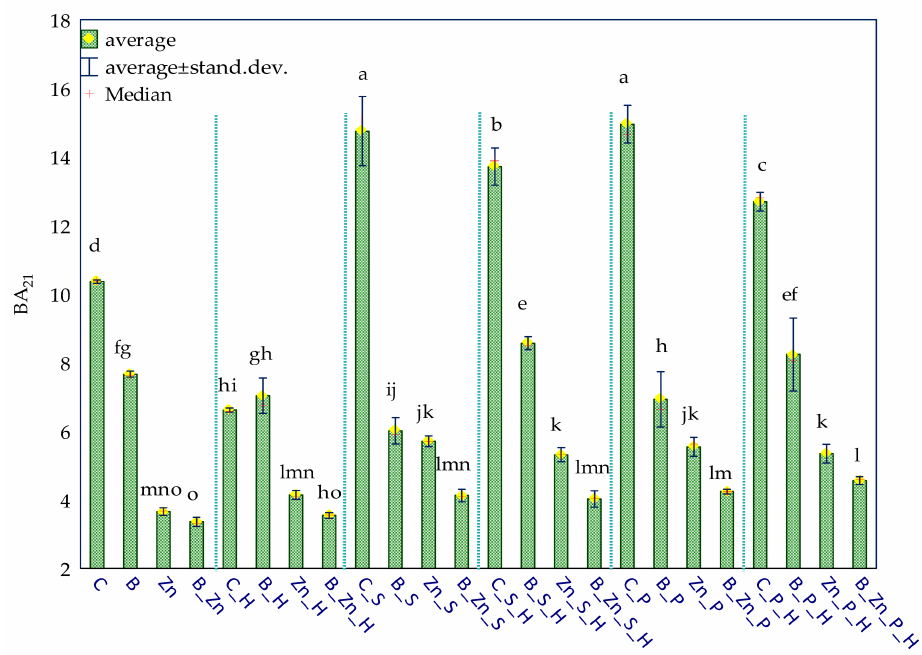
Figure 4. Biochemical fertility index (BA 21 ) of soil uncontaminated and contaminated with B, Zn 2+ , and B + Zn 2+ ; S— Sorghum Moench (S) and P— Panicum virgatum ; C—uncontaminated soil; B—bisphenol A; Zn—ion zinc (Zn 2+ ). Homogeneous groups denoted with letters (a–o) were calcu- lated for all BA 21 index